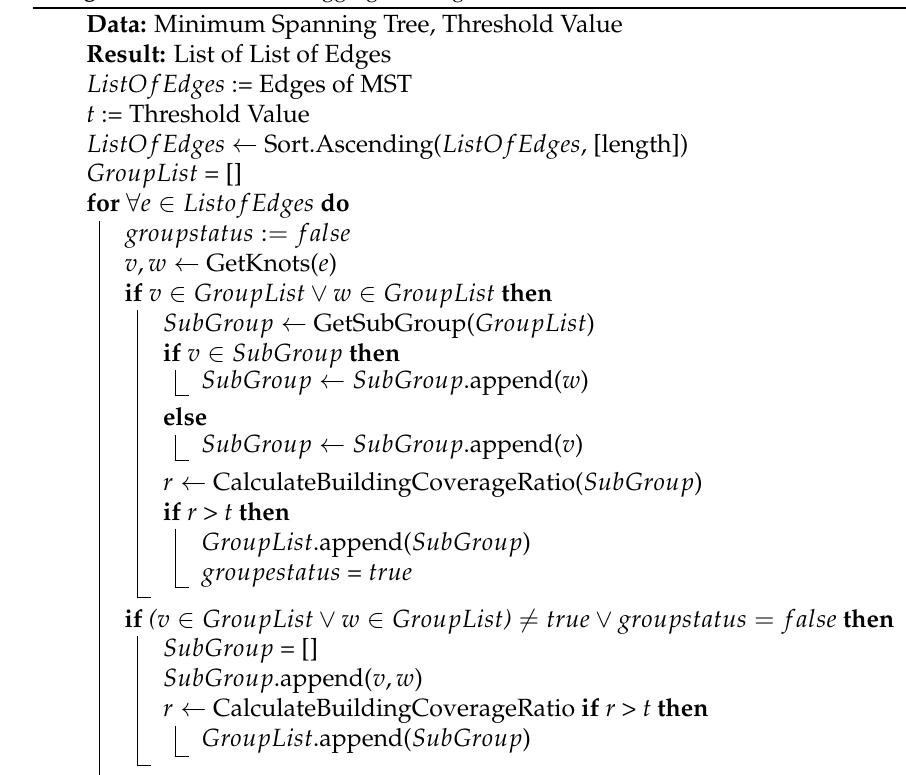
Algorithm 2. MST-based aggregation